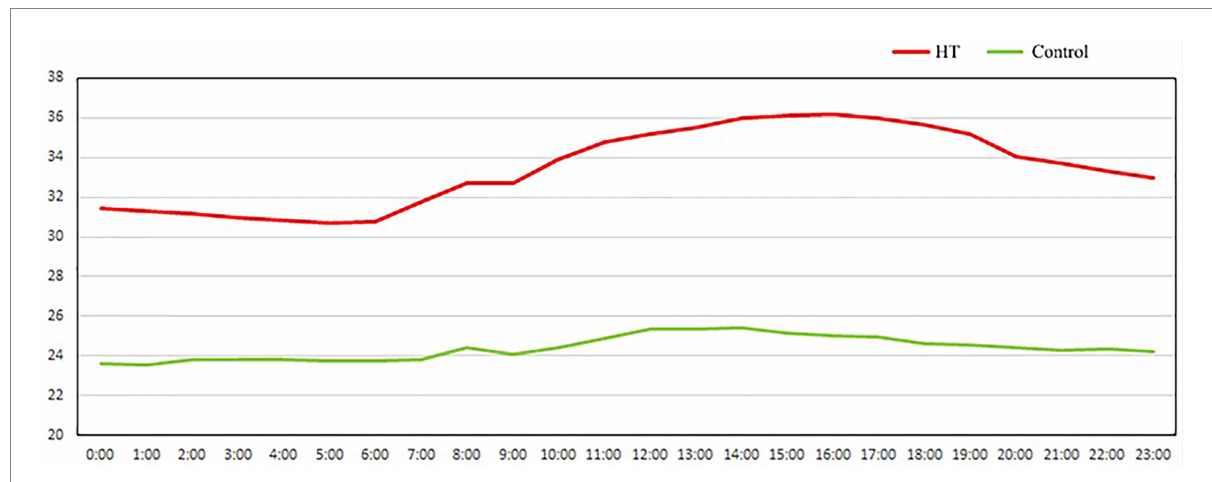
FIGURE 1 The actual average temperature in the room every